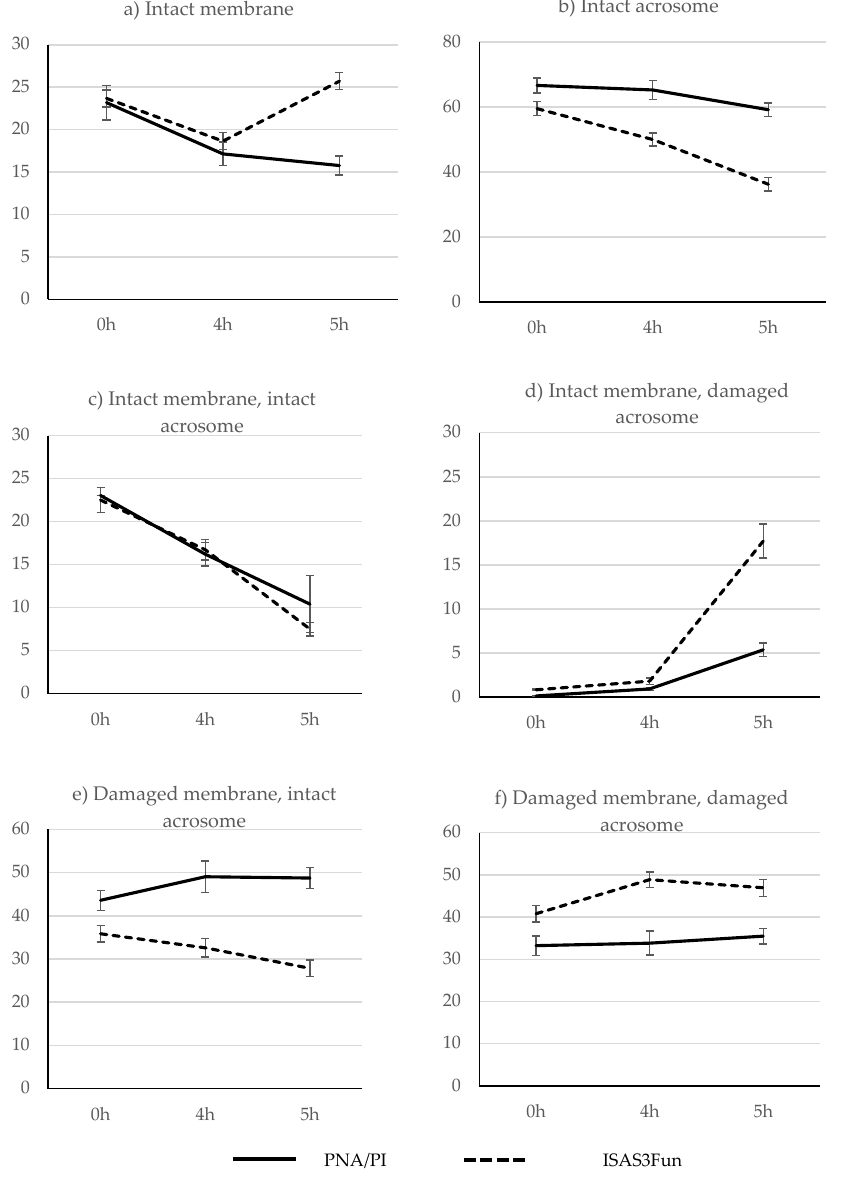
Figure 2. Time evolution of sperm membrane and acrosome integrity using the PNA/PI and the ISAS3Fun fluorescence methods after capacitation (4 h) and ionomycin (5 h) treatment of frozen/thawed bull semen samples ( a – f